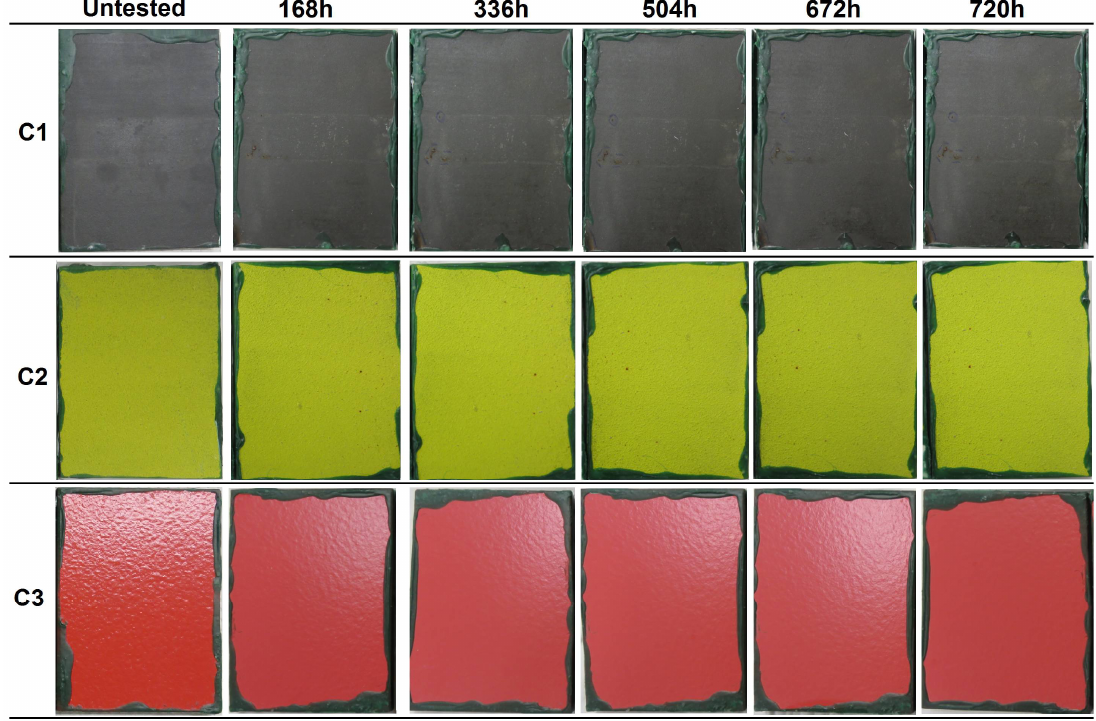
Figure 6. Visual appearance of the coatings’ surfaces at different evaluations during the condensation tests alternating humidity and temperature (AHT) according to the ISO 6270-2 standard.